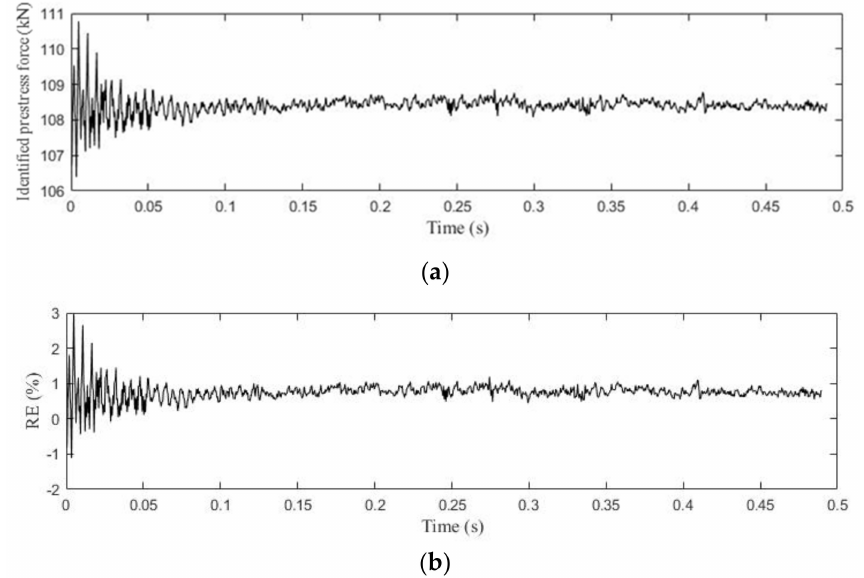
Figure 15. Prestress force identification results: ( a ) The identified prestress force from strain measure- ments. ( b ) The relative error between the simulated prestress force in the FEM and the identified prestress force with strain